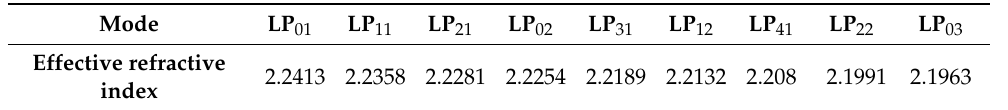
Table 2. Optical mode